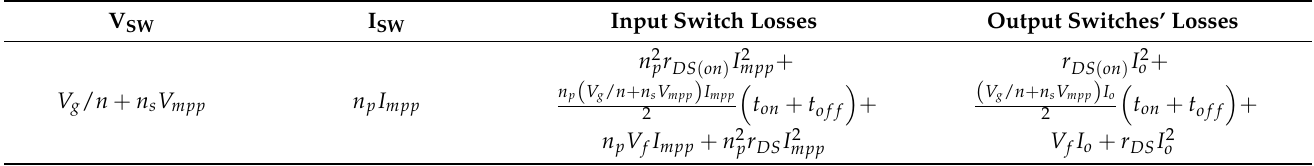
Table 2. Power losses and switches stress of the central Cuk inverter. Table 3. Power losses and switch stress of the modular Cuk